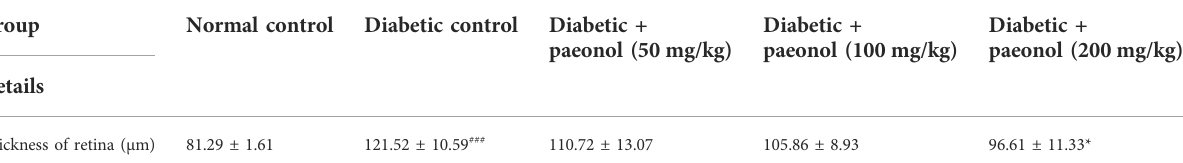
TABLE 3 Effect of paeonol on the retinal thickness of experimental rats.